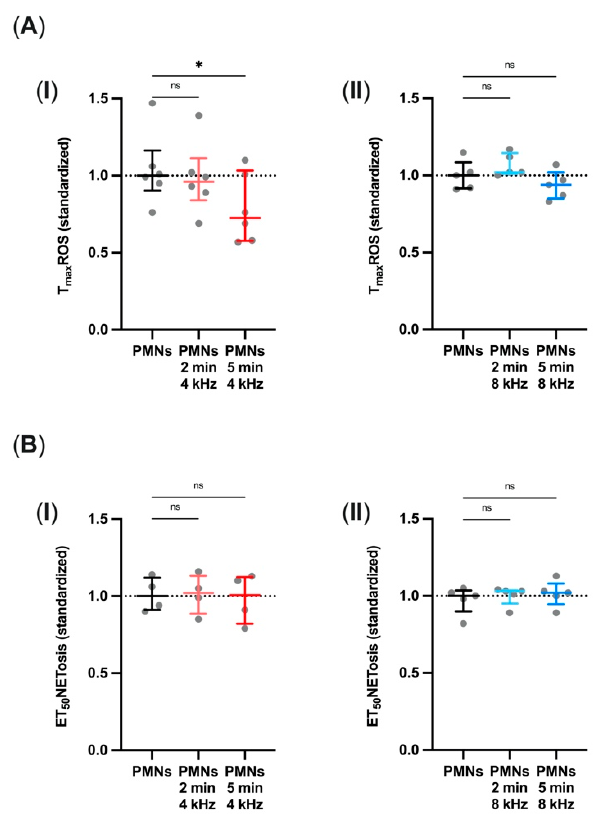
Figure 2. Altered T max ROS without affecting NETosis after CAP treatment. ( A , I , II ) Standardized T max ROS after 4 kHz ( n = 6) or 8 kHz ( n = 5) CAP treatment for 2 min and 5 min. ( B , I , II ) Standardized ET 50 NETosis after 4 kHz ( n = 4) or 8 kHz ( n = 5) CAP treatment for 2 min and 5 min. Both parameters were evaluated by processing the total fluorescent areas per time point during live cell imaging.